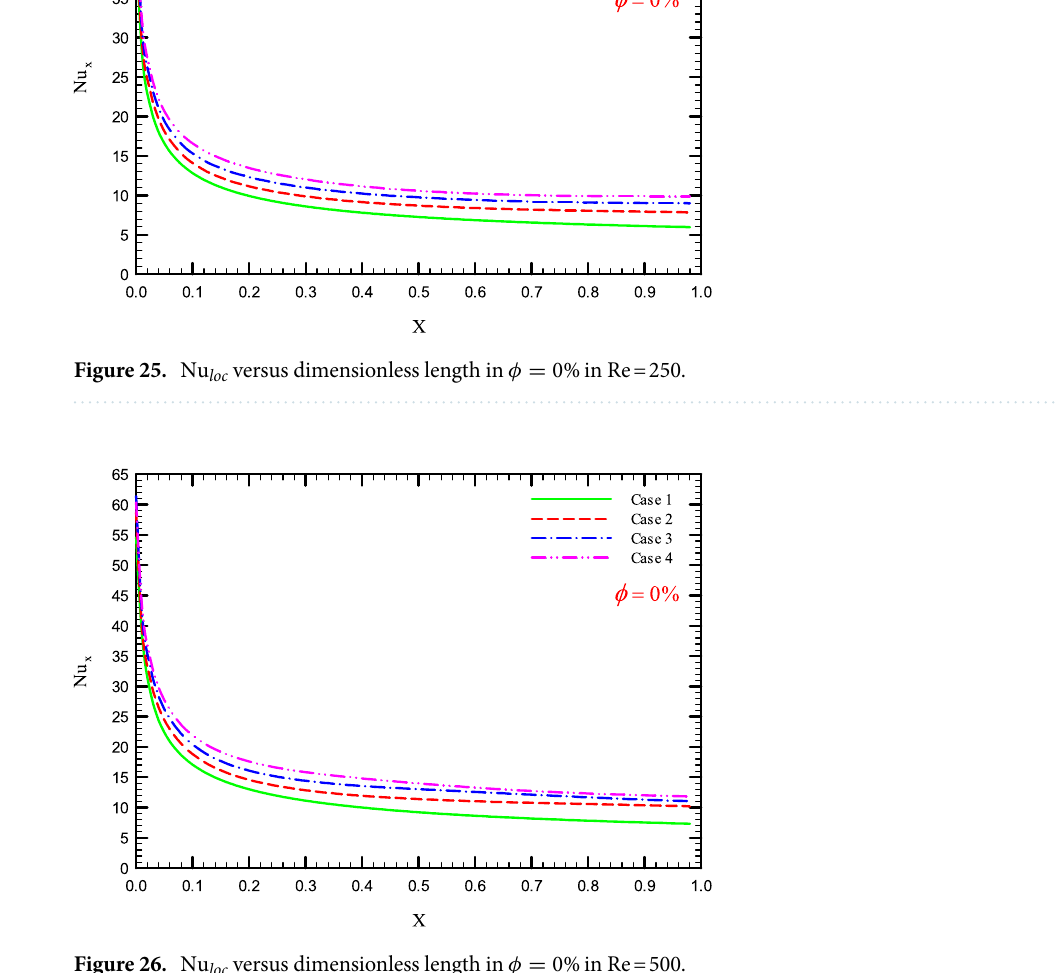
Figure 26. Nu loc versus dimensionless length in φ = 0% in Re =